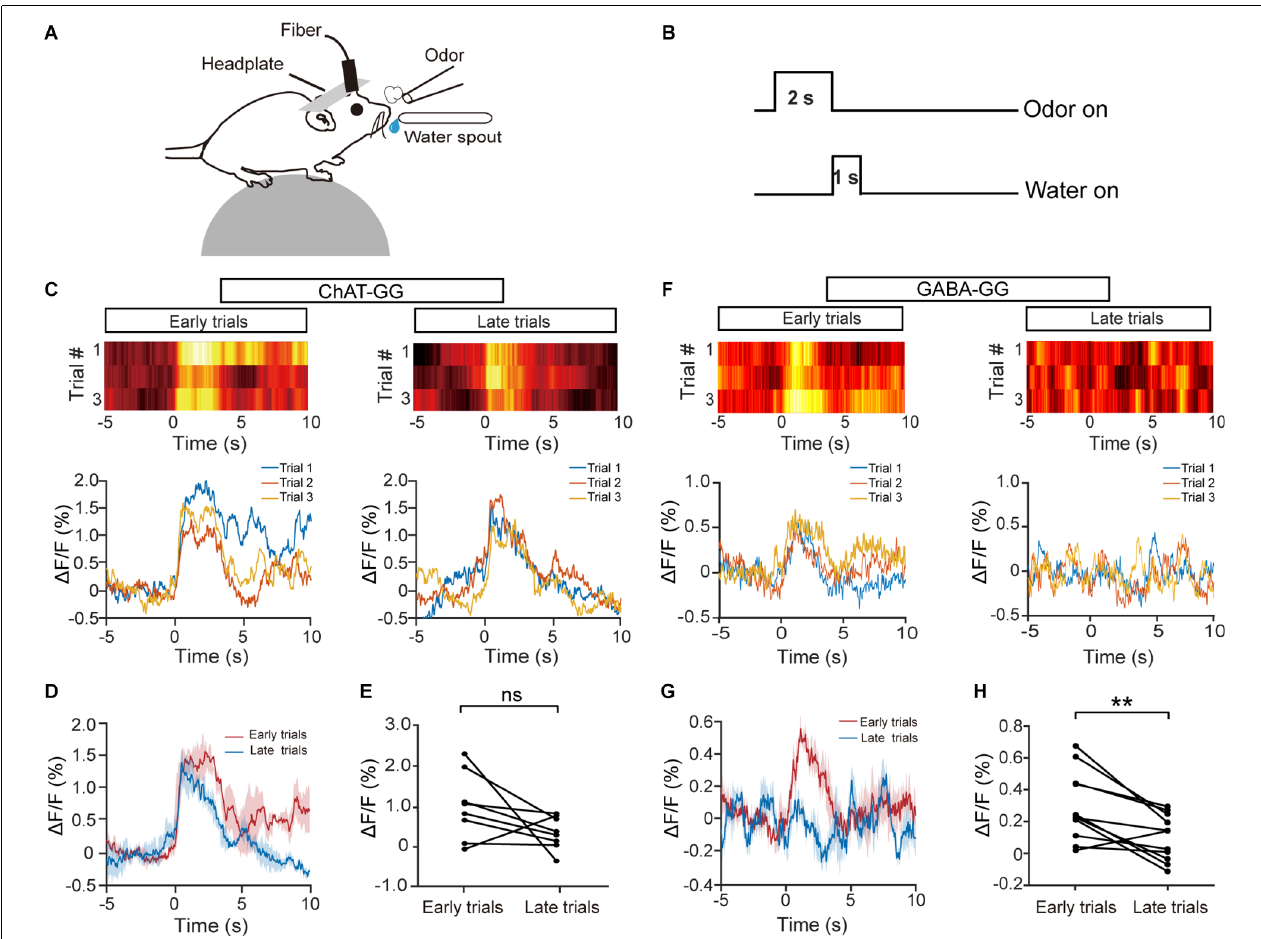
FIGURE 3 | The response profiles of HDB cholinergic and GABAergic neurons during the go/go task. (A) Diagram of the experimental paradigm. (B) Timeline for a single trial in the go/go task. (C,F) Representative heat maps and corresponding traces of the cholinergic (C) and GABAergic (F) responses in the first three trials (early trials) and the last three trials (late trials) of the go/go task. (D,G) The trial-averaged traces of ∆ F/F in (C) and (F) , respectively. (E,H) ∆ F/F in cholinergic (D) or GABAergic (G) neurons across all animal–odor pairs in the early trials and the late trials [ (E) Paired t -test, t (7) = 1.80, P = 0.11; (H) paired t -test, t (10) = 3.69, P = 0.0042]. ns, no significance, ** P <